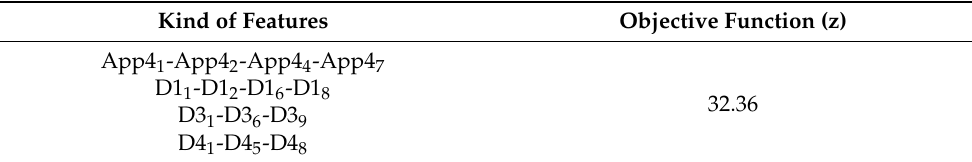
Table 3. Feature selection output—second